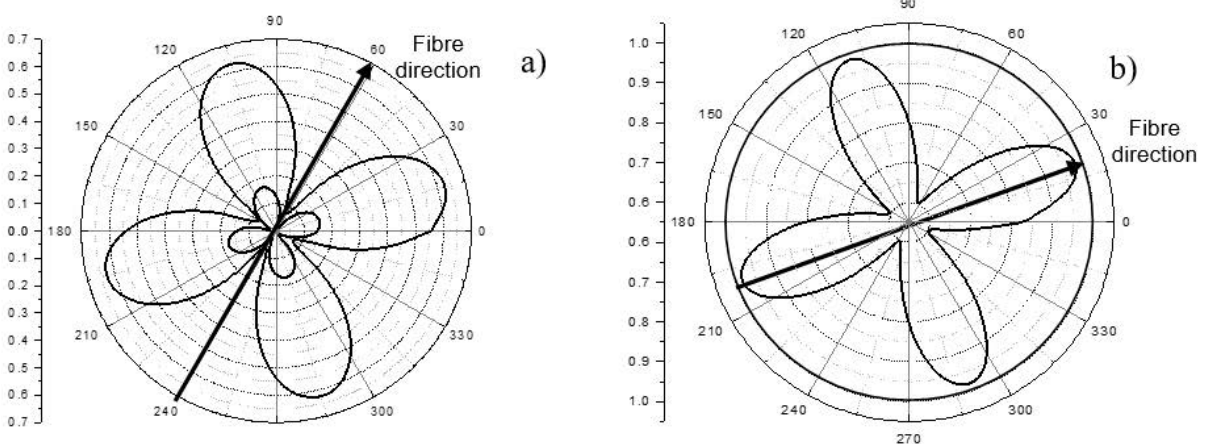
Figure 19. Calculations of V 0 ( γ ) in modes 2 ( a ) and 3–4 ( b ). ( a ) Fibre setup at θ = 60 ◦ ( ∆ ϕ = 80 ◦ for outward and ∆ ϕ = 20 ◦ for inward curve); ( b ) parallel configuration with fibres at θ = 20 ◦ for ∆ ϕ = 80 ◦ and ∆ ϕ = 0 ◦ for outward